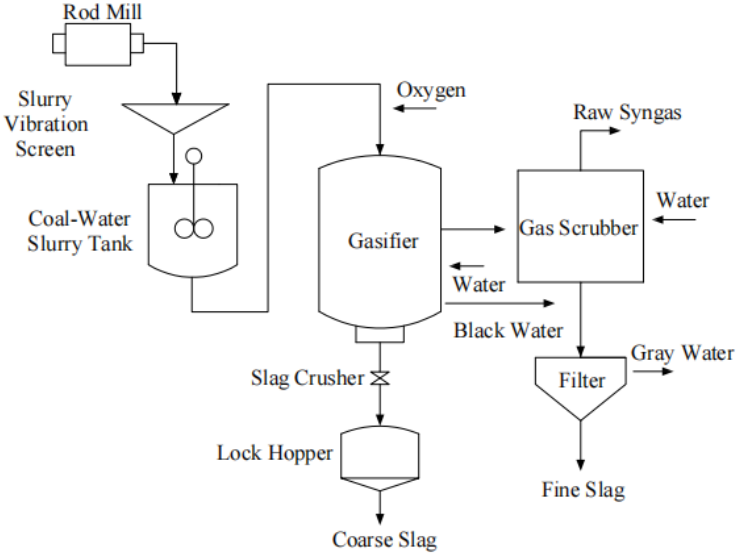
Figure 3. The formation process of CS.